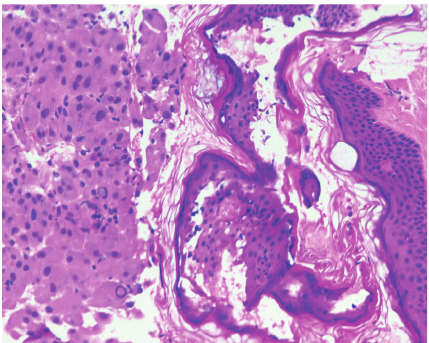
Figure 4: H&E 10 × showing the forehead skin fragment as a contaminant on the right and the tumor on the left (histopathology of forehead lesion).